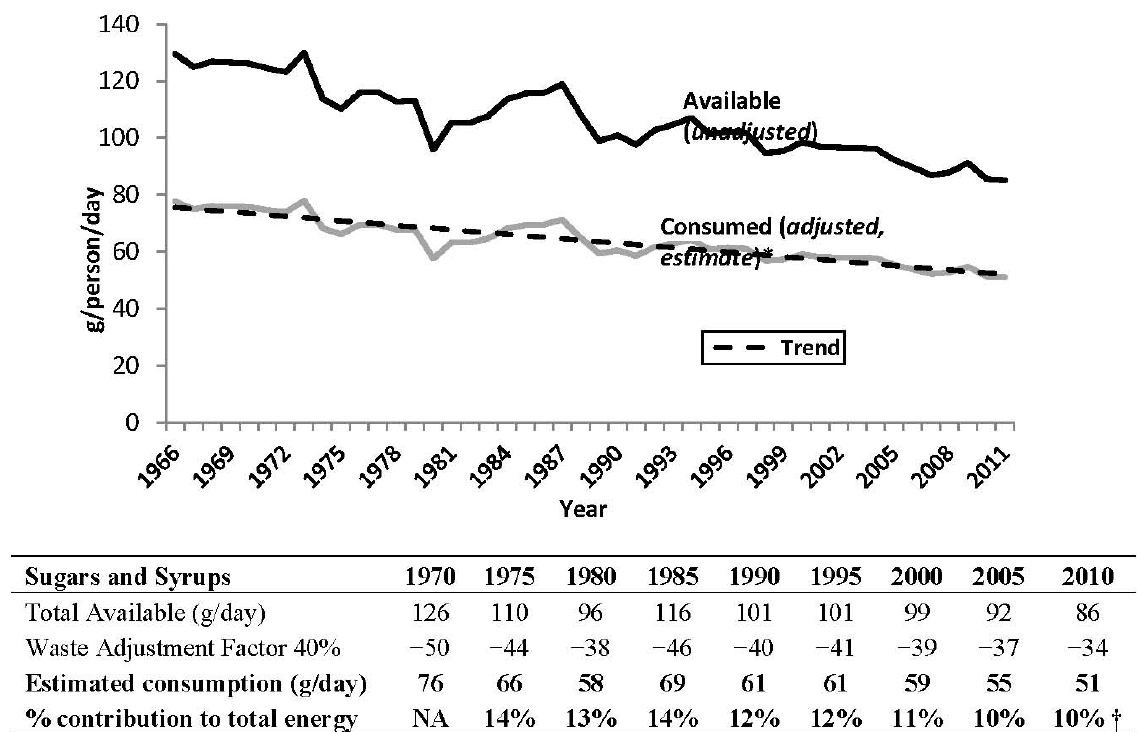
Figure 2. Sugars and syrups available for consumption (unadjusted availability data) and apparent consumption (adjusted availability data) in Canada from 1966 to 2011. Source: Statistics Canada (2012). * Experimental data, use with caution. Availability data